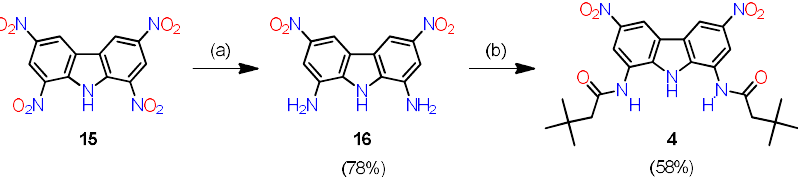
Figure 2. 1 H NMR titration curves of the ( a ) NH carb. and ( b ) NH amide signals of receptors 1 – 4 (10 mM) for TBACl in DMSO-d 6 + 0.5% H 2 O at 298 K. The 1:1 modeled fits are shown as solid lines.